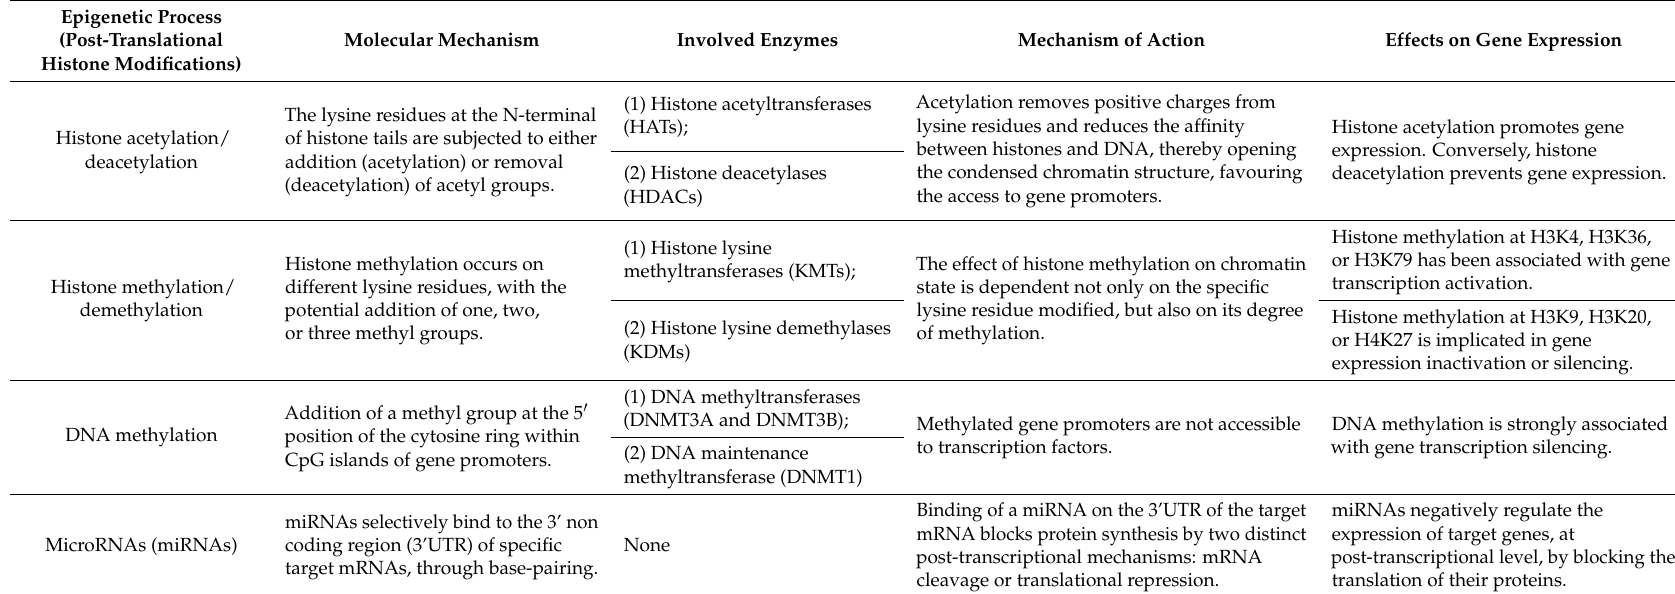
Table 1. Main epigenetic mechanisms and their principal effects on gene